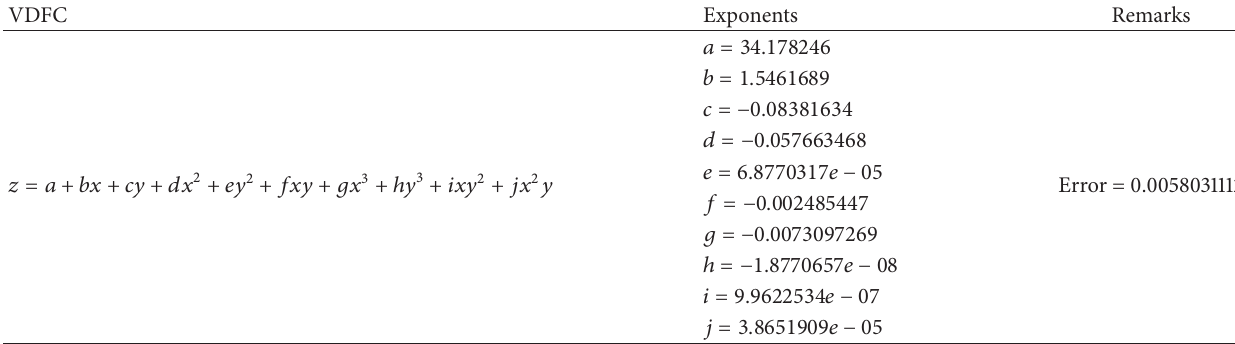
Table 1: An approximate analytical formula for the VDFC of 42CrMo